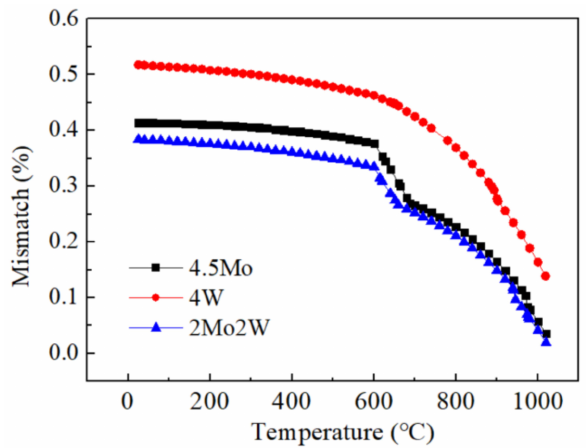
Figure 11. Mismatch of the γ and γ (cid:48) phases for alloys with different W and Mo